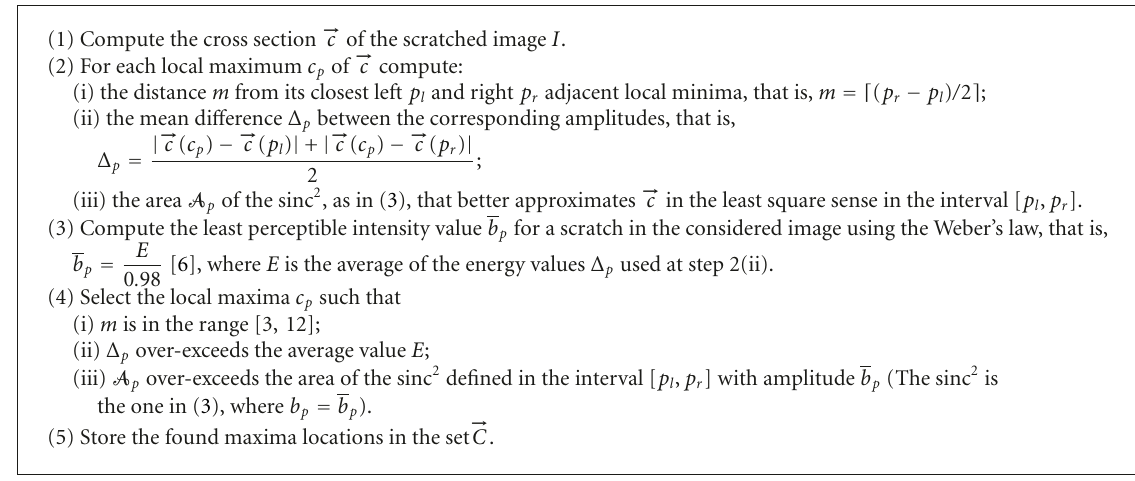
Algorithm 1: Algorithm for the detection of black and white scratches.